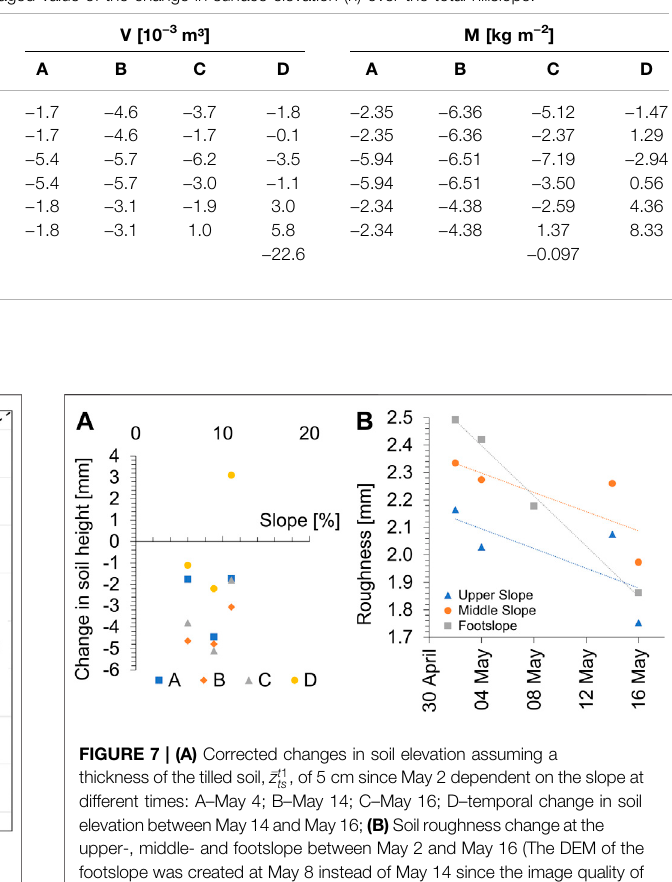
TABLE 3 | Weighted changes in average soil surface elevation (h), volume (V), and mass (M) at the SfM-plots along the experimental slope between May 2 and A: May 4, B: May14,andC:May16;DindicateschangesinsurfaceelevationandmassbetweenMay14and16aftercorrectionforsoilsettlement;mass,M,collectedatthehillslope erosion station between May 2 and 16 (C) was used to calculate a slope-averaged value of the change in surface elevation (h) over the total hillslope.